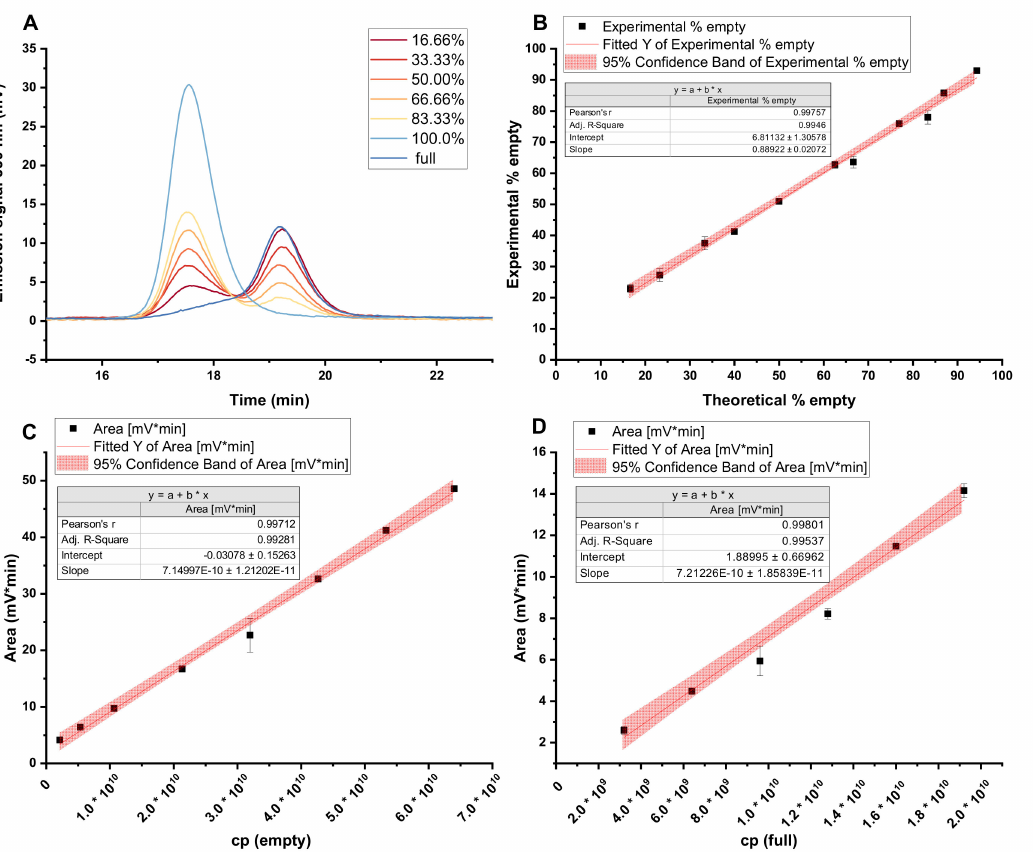
Figure A1. Calibration data of the Protein-Pak Hi Res Q, 5 µ m, 4.6 × 100 mm. ( A ) Depiction of the raw data of the chro- matograms showing the amount of empty capsids in percent. ( B ) Experimentally determined percentage values of empty capsids plotted against the theoretical percentage. ( C , D ) Calibrations of empty capsid ( C ) and full rAAV ( D )